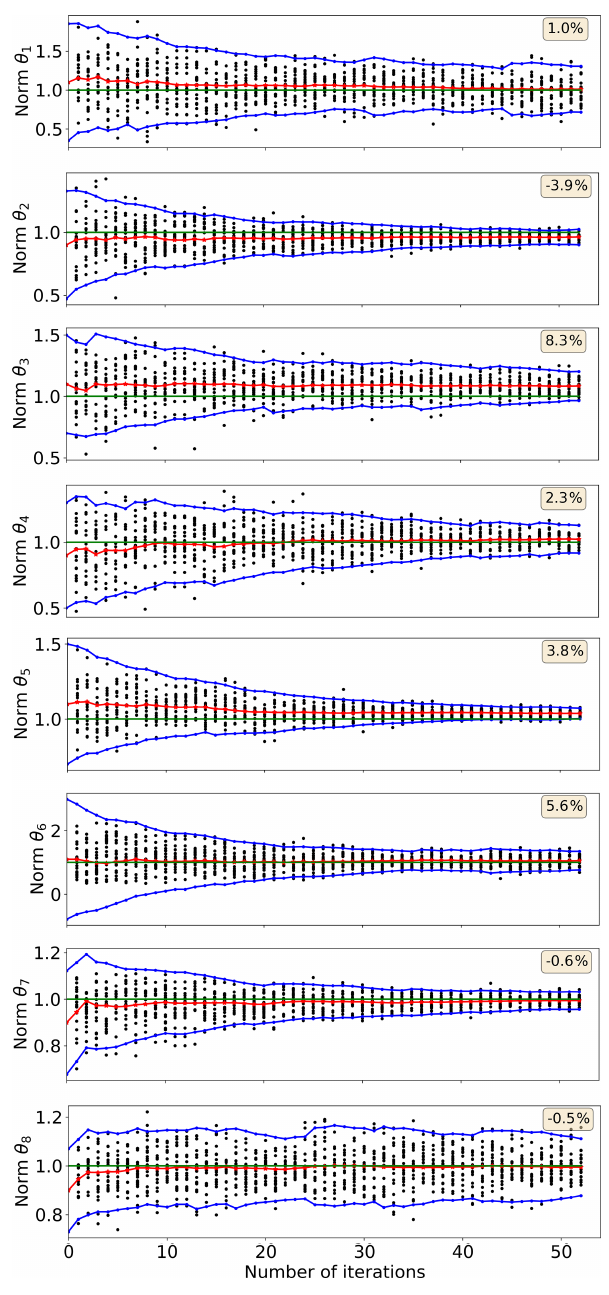
Figure 7. Progress of the convergence in the eight-parameter test. The parameter values and uncertainties have been normalised with their default values. Black dots show sampled parameter values, the red line with stars shows parameter mean value, blue lines with dots show mean value ± 2 standard deviations, and the green line shows the default parameter value that is 1.0 due to the normalisation. The text boxes indicate the remaining parameter offset, which is the rela- tive distance between the final parameter mean value and the default value. Initial parameter offset is randomly ±